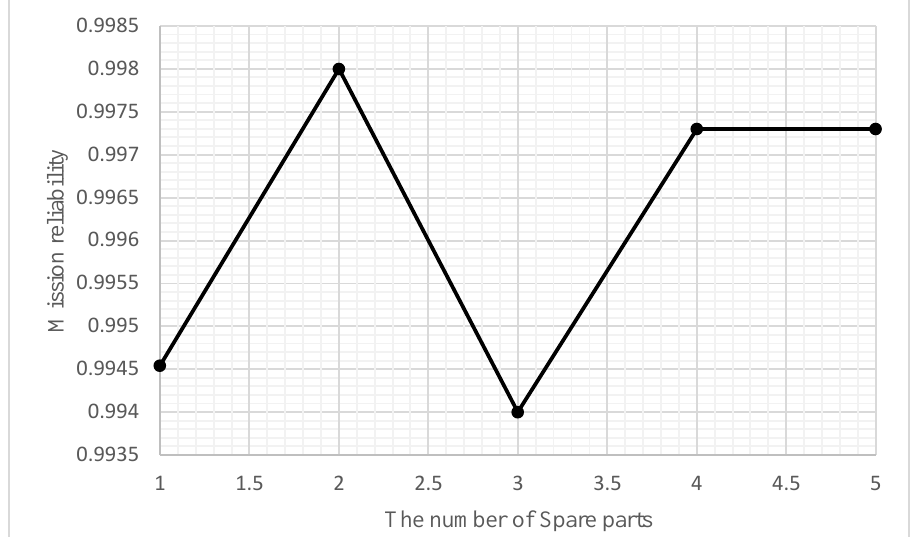
Figure 19. Influence of spare part number on mission reliability (short time task).